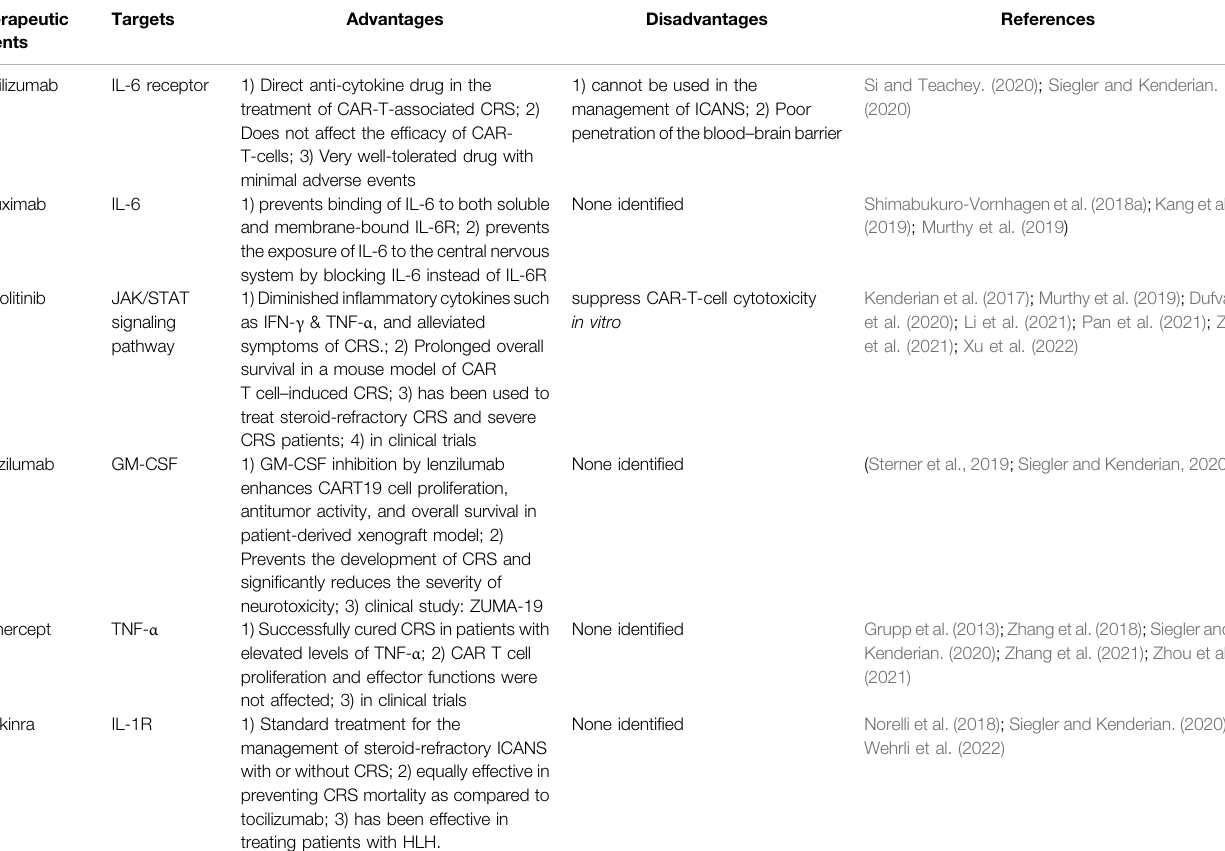
TABLE 3 | Therapeutic agents against the targets that play a major role in